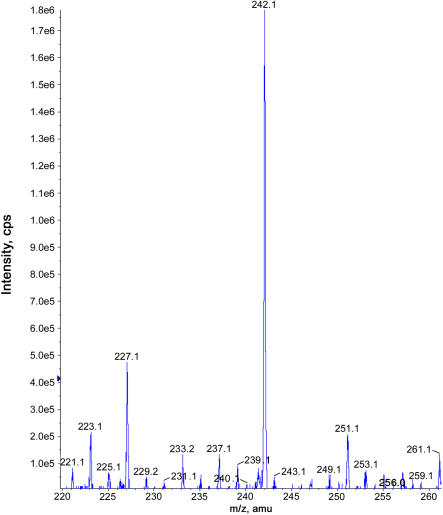
ESI-MS/MS Analysis, in the Positive EPI Scan Mode, of a Purified
Sorghum Extract Active in a
Gi. rosea Hyphal Branching Assay
The parent ion m/z = 339 shows the characteristic daughter ion of sorgolactone [M + Na]
+ at m/z = 242.